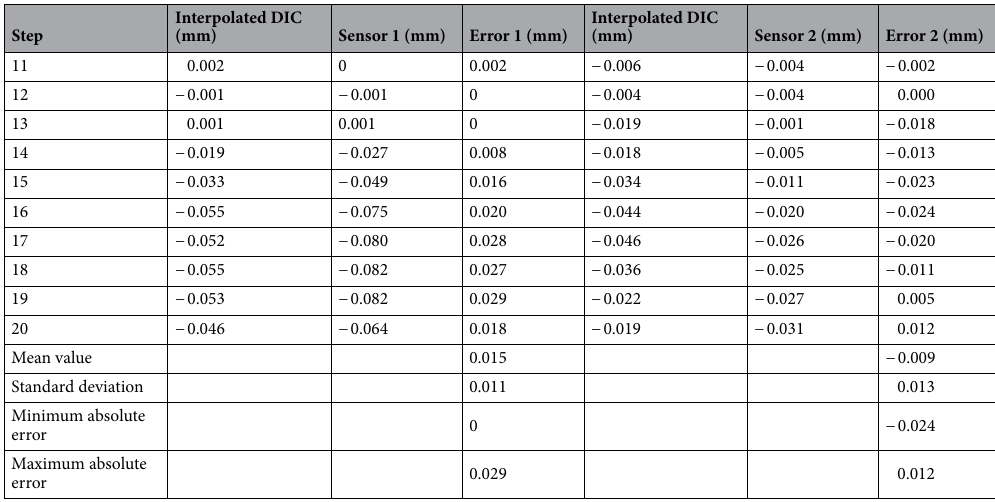
Table 2. Comparison between the deformation according to the sensors and the DIC-based